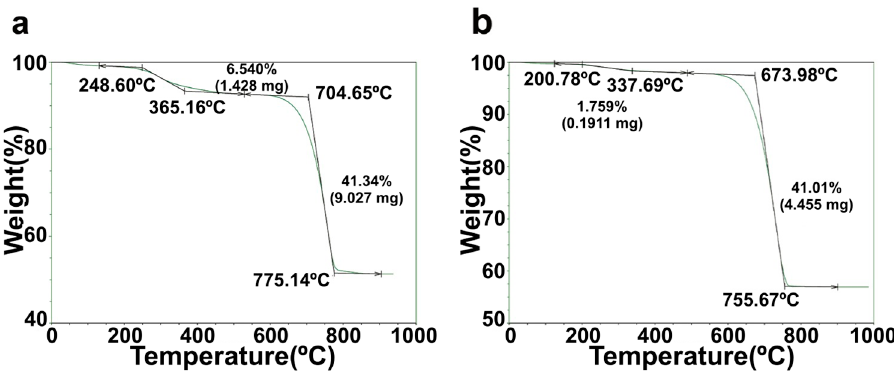
Figure 2. The TGA patterns of ( a ) crushed green mussel shells and ( b ) mixed shell powder. The fraction of decomposed green mussel shells and mixed shell powder ( α ) was calculated using Equation (2) [17]. The weight loss with respect to the total weight loss of the samples was used to calculate the fraction of decomposed green mussel shells and mixed shell powder. The initial weight is denoted by Wi and Wt denotes the current weight. The final weight is denoted as Wf.